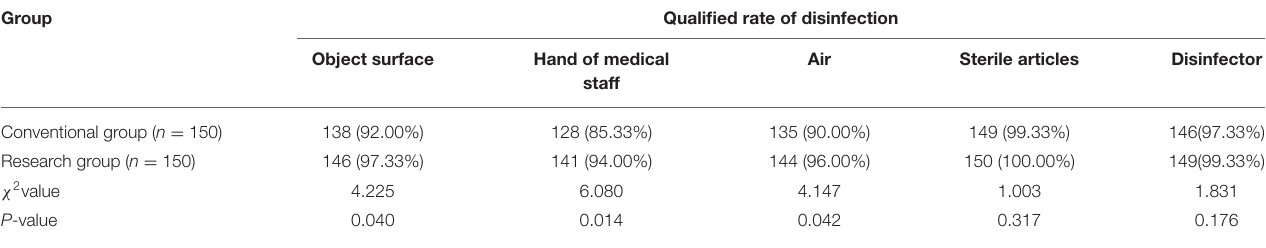
TABLE 4 | Infection control in the two groups ( n , %).